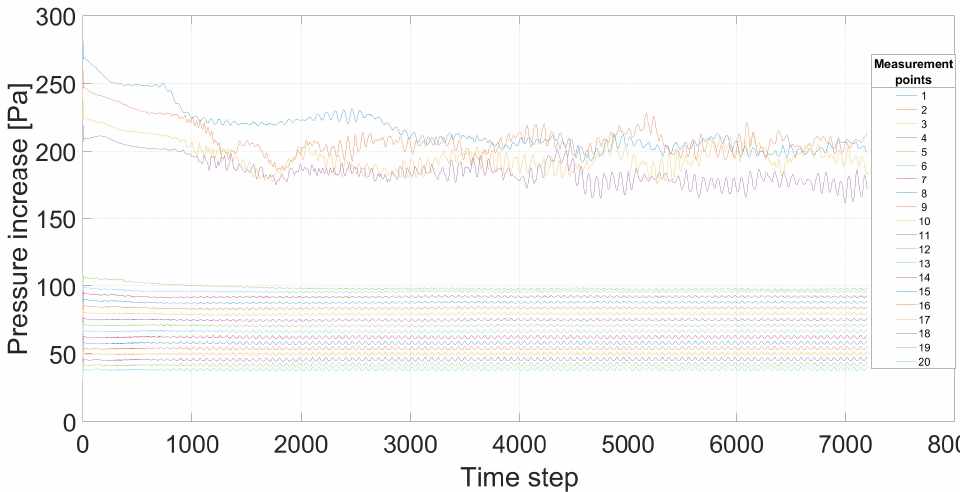
Figure 6. Pressure increase.